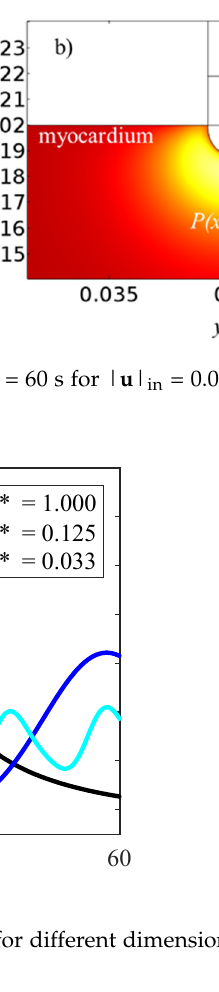
Figure 3. Tissue temperature fields for | u | in = 0.05 m/s, V 0 = 22.5 V, ( a ) ω * = 1.000 ( t = 30 s) and ( b ) ω * = 0.033 ( t = 60 s).